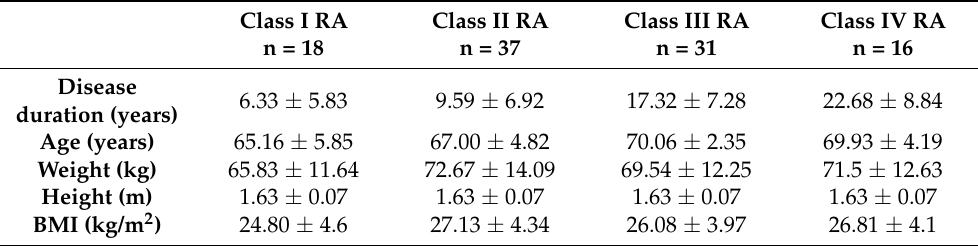
Table 1. Age and anthropometric measurements of patients with RA depending on disease severity according to the Steinbrocker